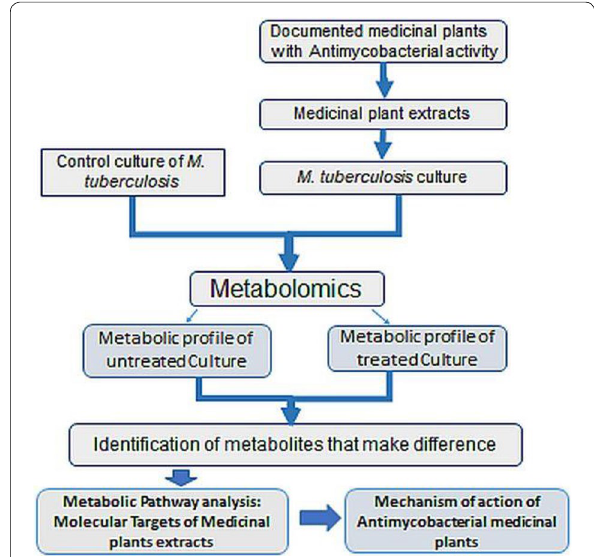
Fig. 4 Application of metabolomics to understanding the mechanisms of action of medicinal plants with anti‑tuberculosis activity: The metabolic profile of the M.tb culture with or without the treatment with antimycobacterial medicinal plant extracts is determined by applying Metabolomics. The change in metabolome of the culture with the treatment is caused to the activity of plants extracts. The metabolites that make difference between the treated and untreated cultures will allow to elucidate the metabolic targets of medicinal